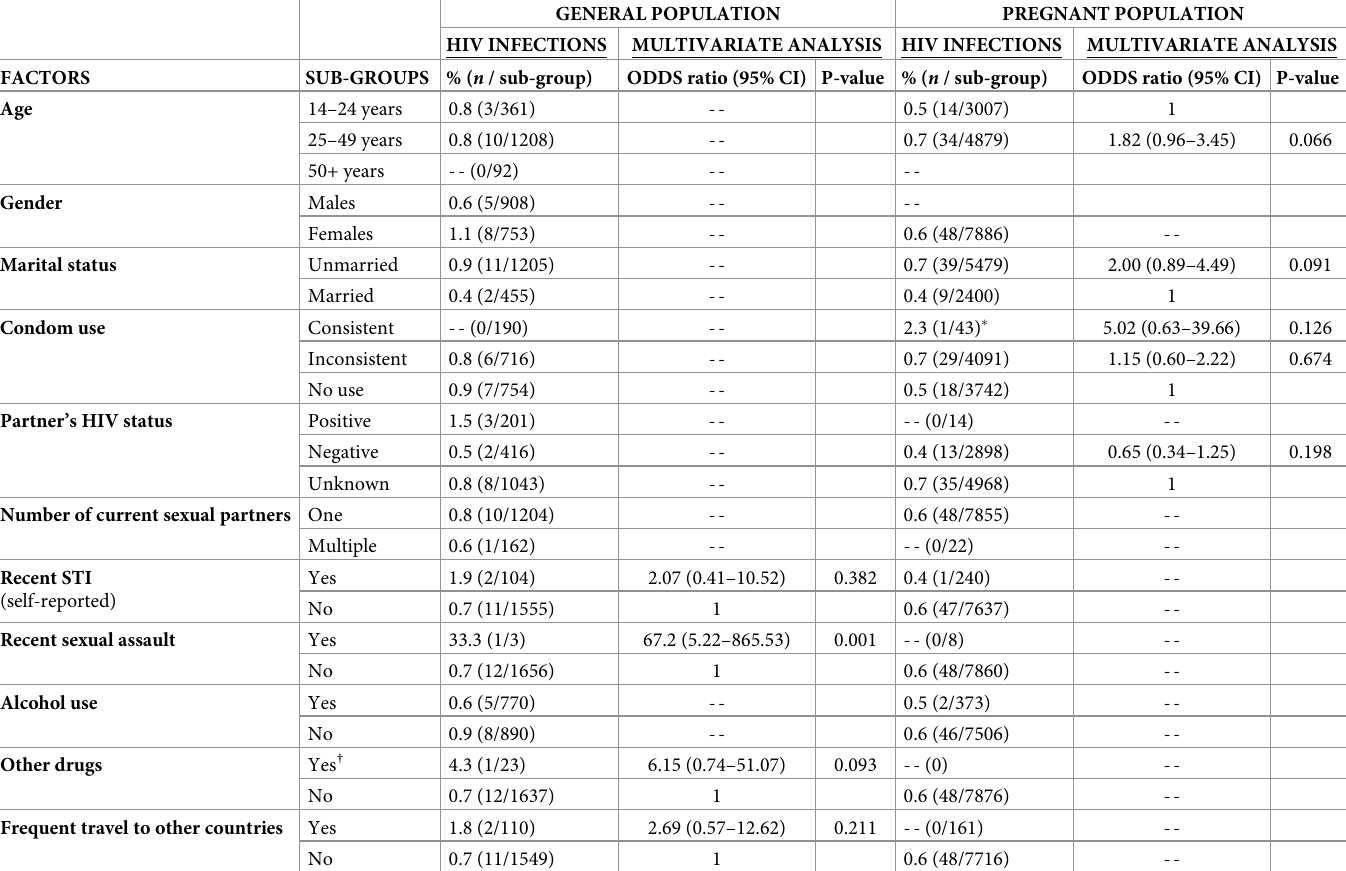
Table 3. Multivariate analysis of factors associated with HIV